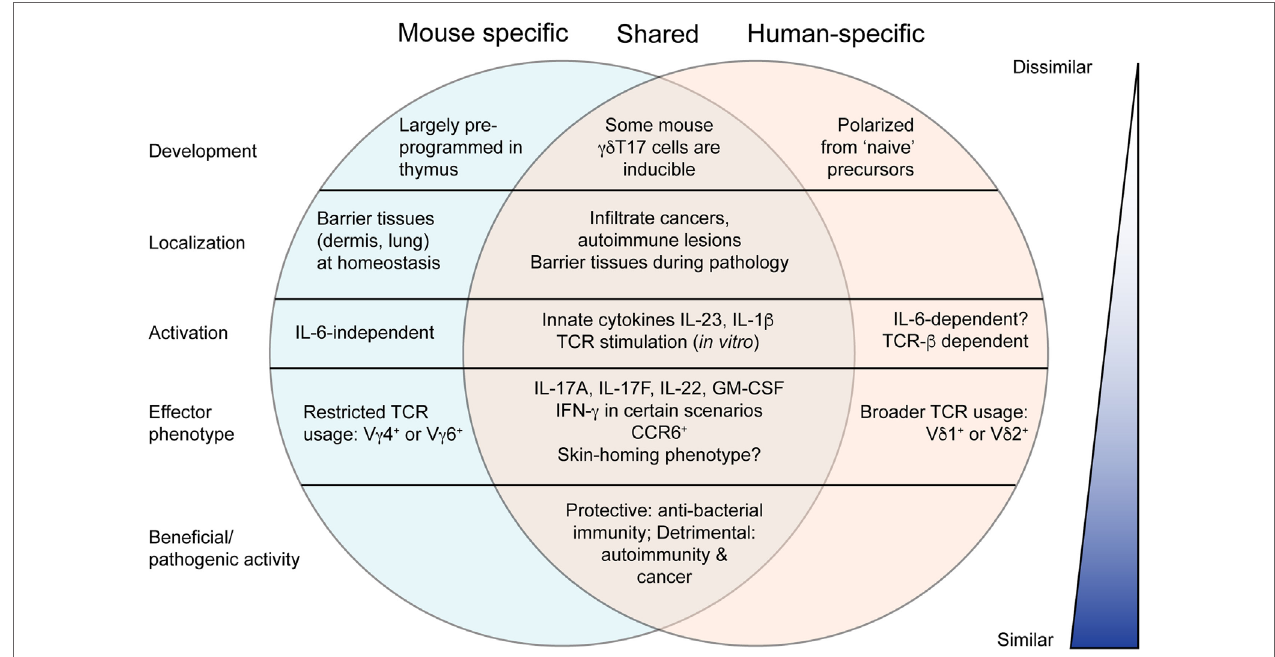
FigURe 3 | Comparison of murine and human γδ T17 cells. Murine γδ T17 cells are preprogrammed, tissue-localized innate-like sentinels that respond to innate cytokines. Human γδ T17 cells are very rare and develop from naïve precursors upon T cell receptor (TCR) stimulation. However, there are many similarities between mouse and human as outlined. Most notably, mouse and human γδ T17 cells are beneficial or pathogenic in highly similar scenarios, suggesting that knowledge from mice may be useful to promote antibacterial immunity or treat autoimmunity and cancer in humans. Moreover, further research to clarify emerging concepts discussed in this review may reveal greater